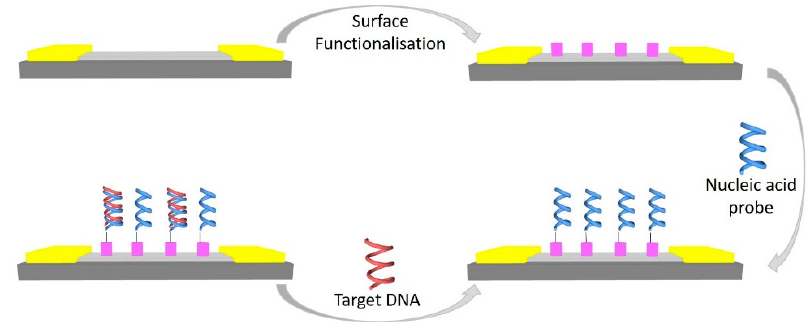
Figure 2. A schematic representation of the process flow for developing a G-FET for nucleic acid detection. Gold—Contact pads, dark grey—SiO 2 , light grey—graphene, purple—surface functionalisation.